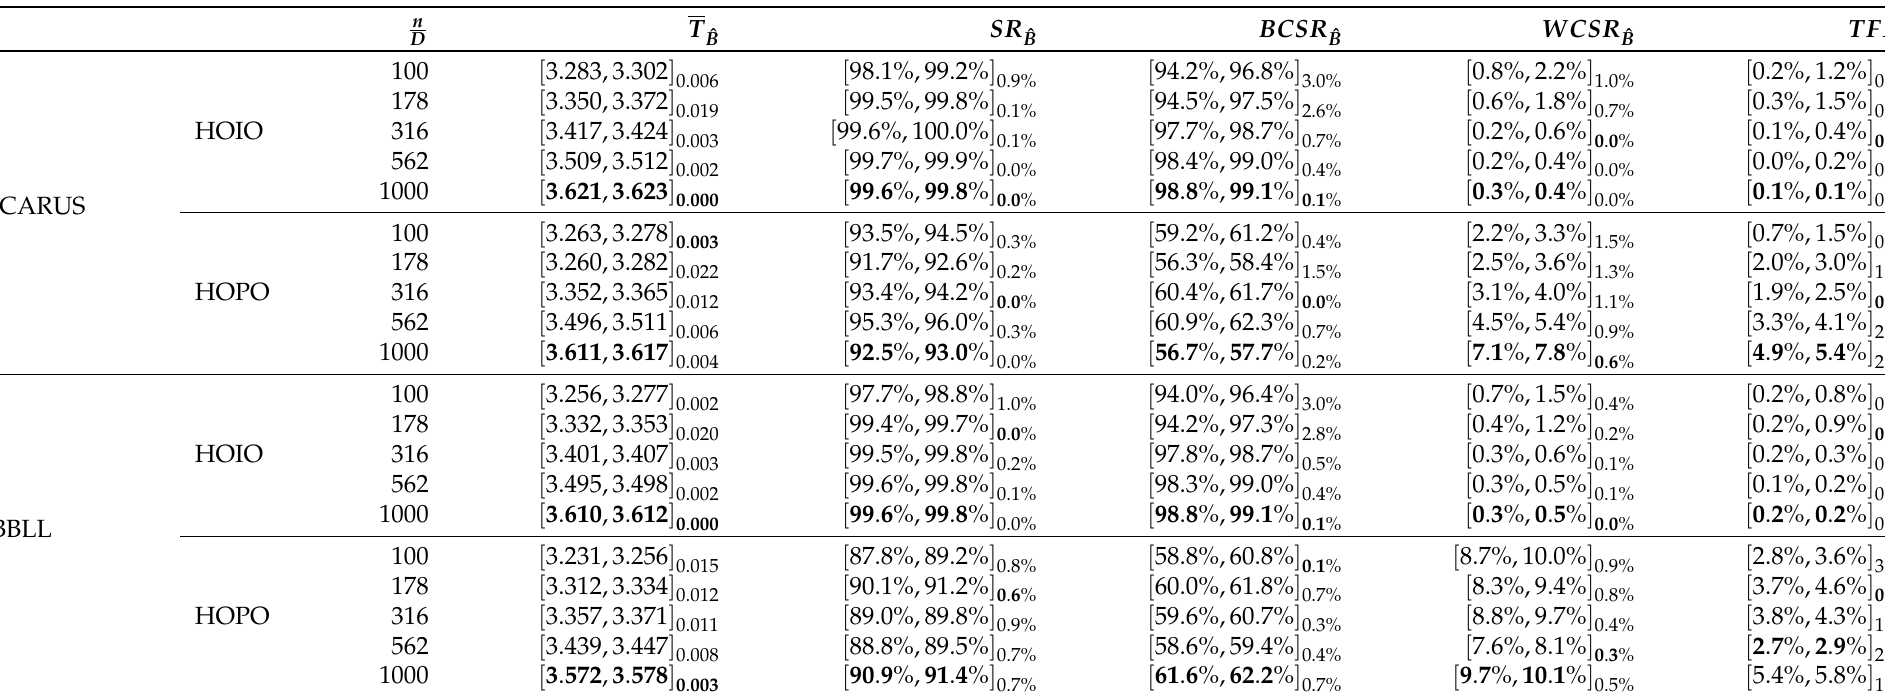
(cid:8) (cid:9) T , SR , BCSR , WCSR , TFR Table 5. Bootstrapped 95% CI of . The sub-index represents the bias of the estimation. In boldface are those intervals whose range is the smallest for a given validation, and the lowest